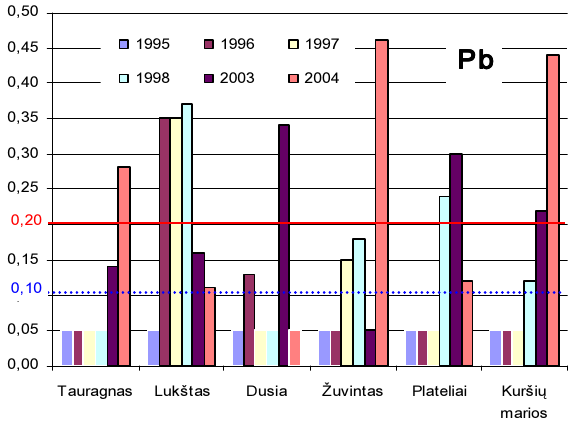
Fig. 10. Dynamic of heavy metal (Cr) concentrations (mg/kg) in perch and roach muscles from monitored water Lyginant kontrolines ir paveiktas žuvų grupes nusta-